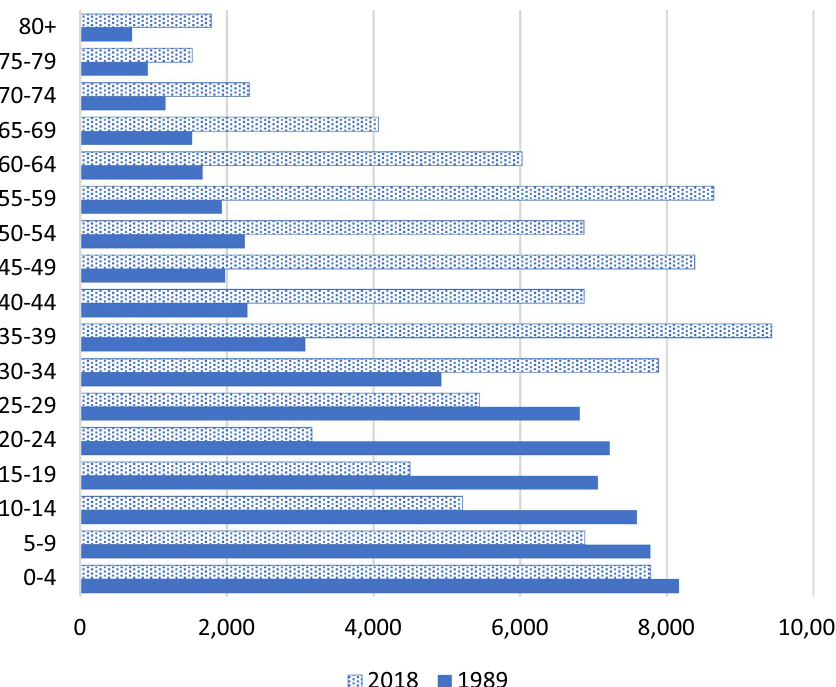
Figure 1. Age structure of the population of Seychelles in 1989 and